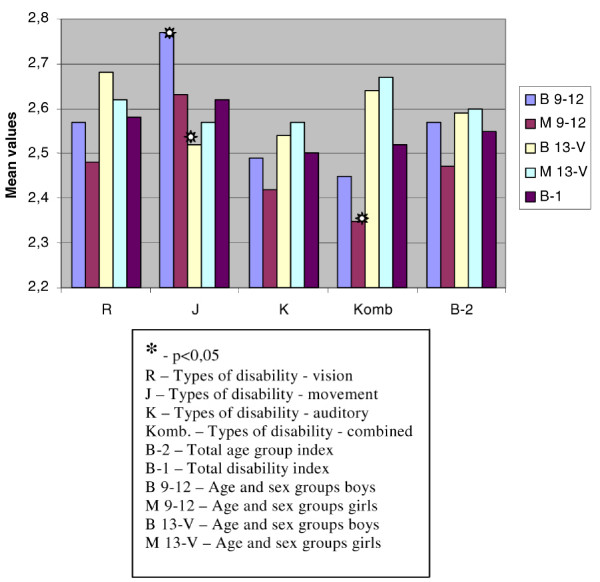
The self-awareness component of schoolchildren with disabilities by age, sex, and the type of disability. The relationship between the self-awareness component (SKX) of disabled schoolchildren's feelings towards their disabled peers, and their age, sex (girls, boys), and the type of disability (vision, movement, auditory, combined).